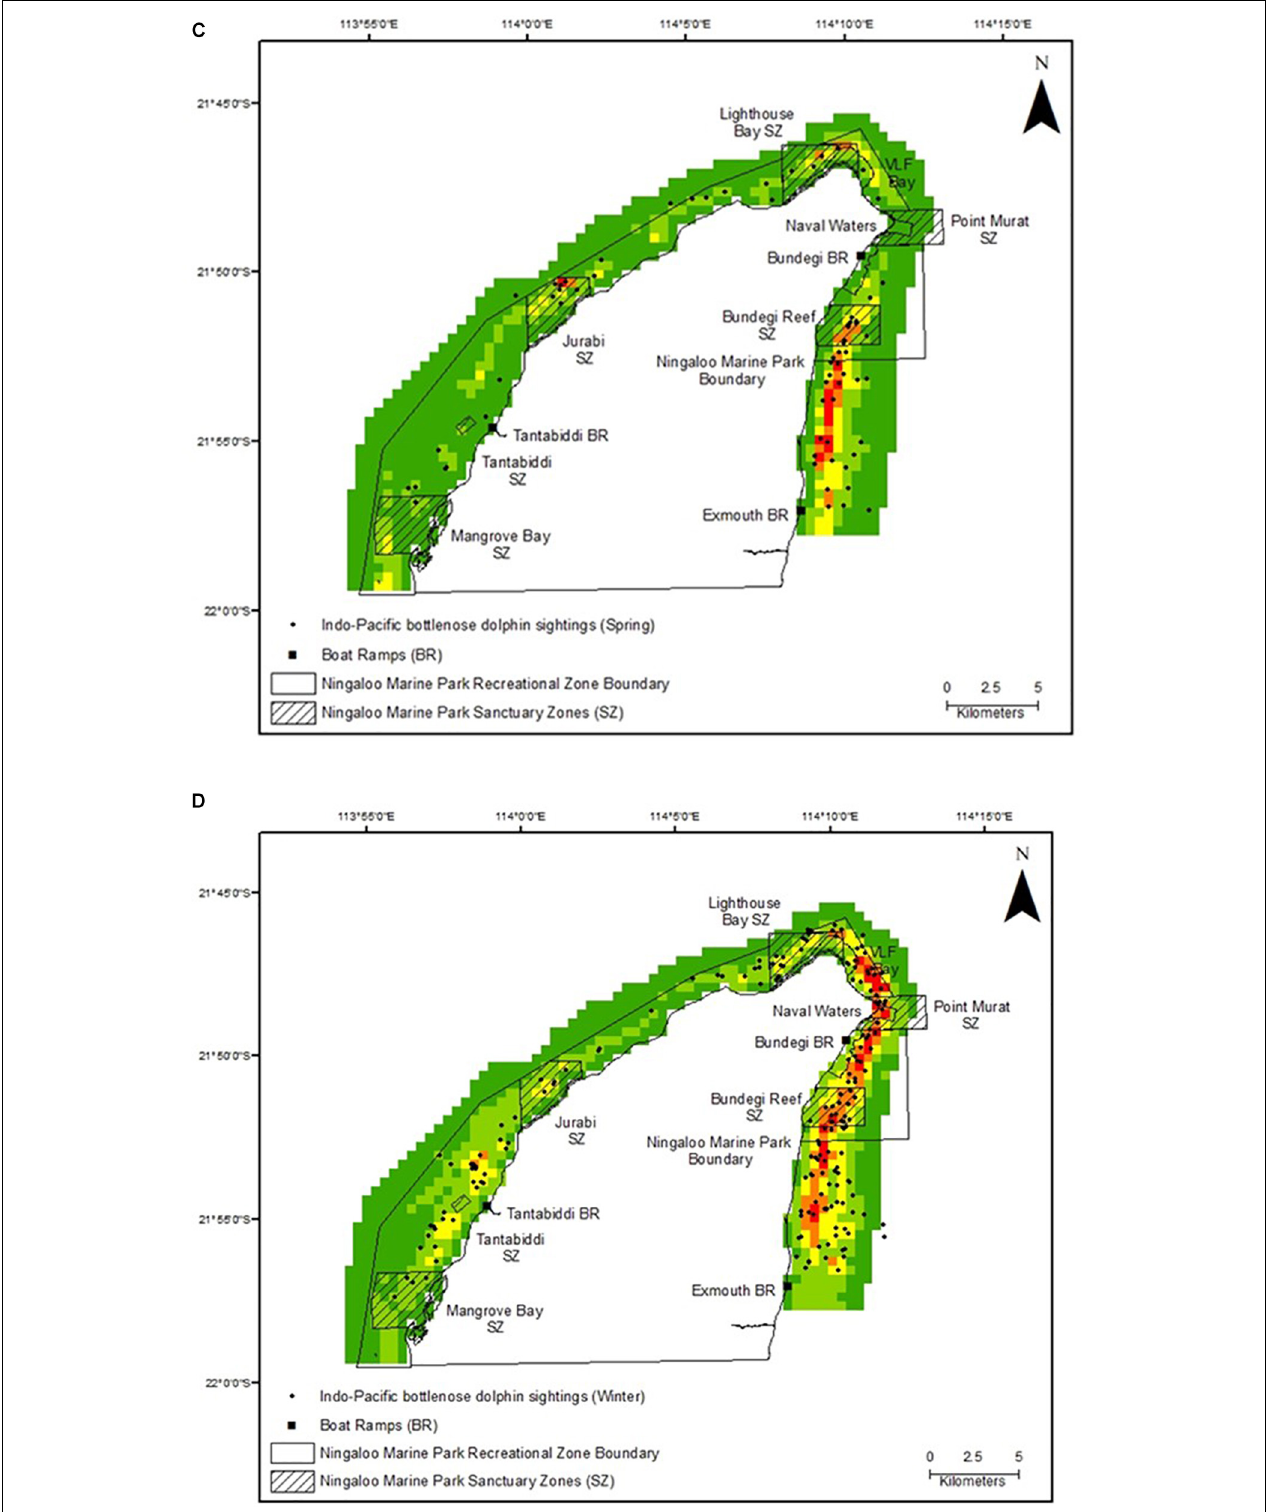
FIGURE 5 | Ensemble models of Indo-Pacific bottlenose dolphin probability of occurrence at the North West Cape, Western Australia for the overall (A) ensemble and each season ( B : autumn; C : winter; and D : spring). Colors as shown in the legend indicate the probability of occurrence 0 . 00 − 0 . 40 = low, 0 . 41 − 0 . 80 = moderate and 0 . 81 − 1 . 00 = high. The General Use Zone is the area outside the Recreational Zone boundary.